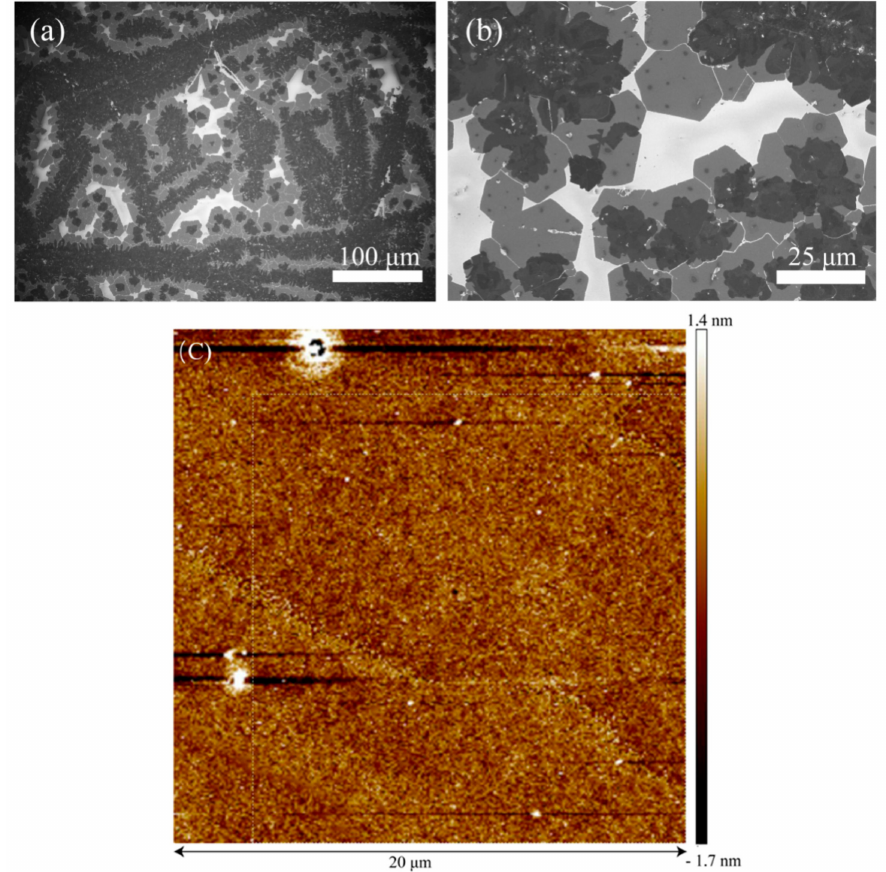
Figure 3. ( a , b ) Typical field emission scanning electron microscopy (FESEM) images of the WS 2 film. Images (a,b) were taken at di ff erent locations. ( c ) Atomic force microscope (AFM) image of 1:1 Poly-TPD and PCBM